Question: Generate an informative caption for the figure above.
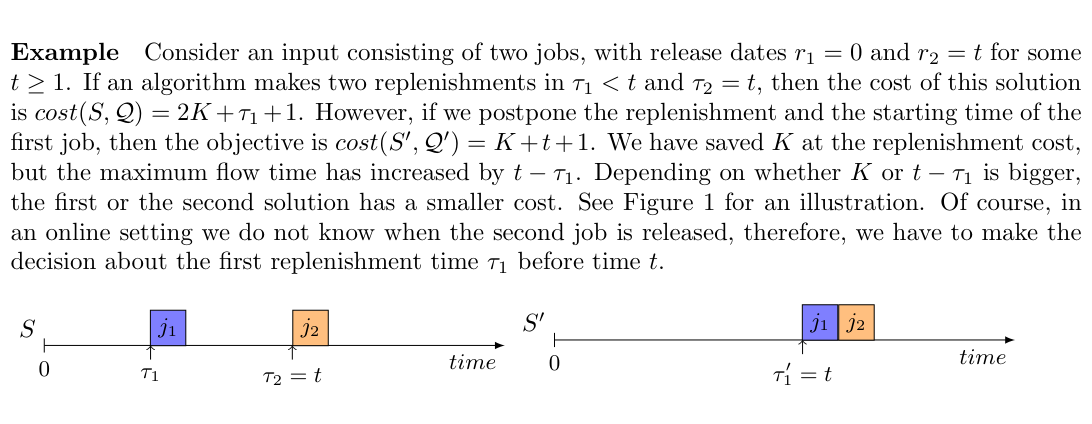
Answer: Two feasible solutions. The arrows below the axis denote the replenishments.